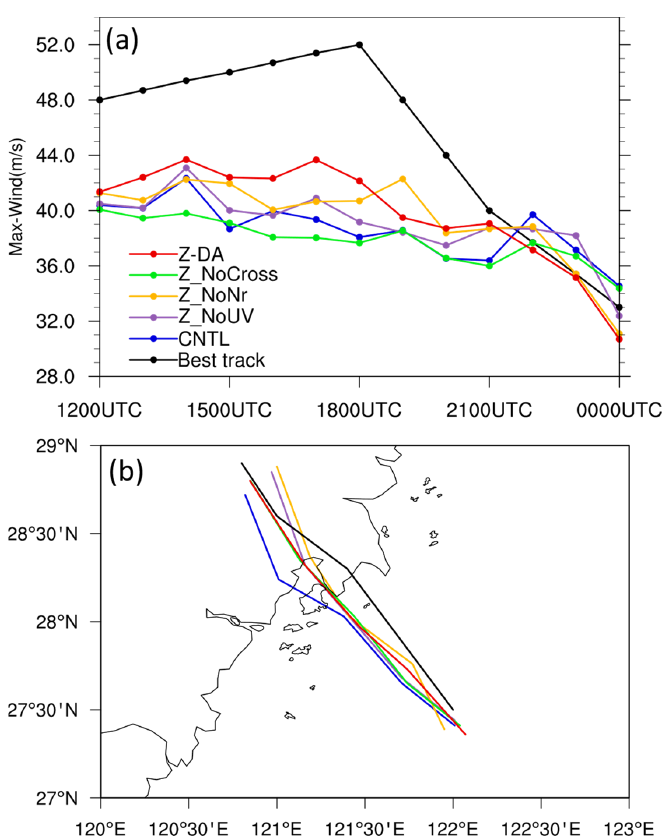
Figure 9. As in Figure 5, but for experiments Z-DA (red lines), Z_NoCross (green lines), Z_NoNr (orange lines), Z_NoUV (purple lines), and CNTL (blue lines). Predicted ( a ) maximal wind speed and ( b ) track for 12 h forecasts from 1200 UTC, 9 August, to 0000 UTC, 10 August 2019.